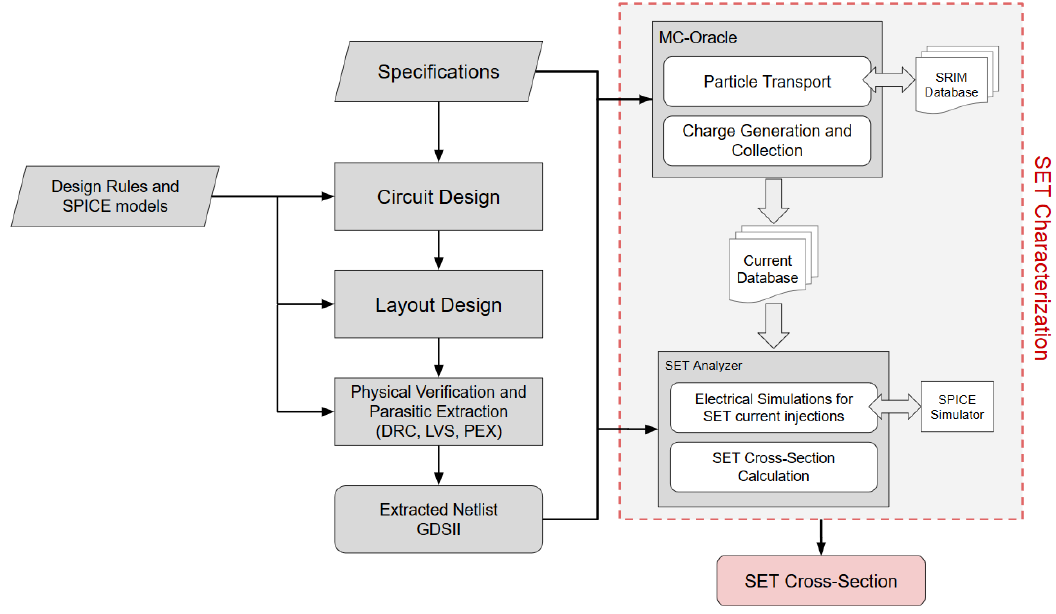
Figure 2. Simplified full custom design flow integrated to the Single-Event Transient (SET) characterization flow.